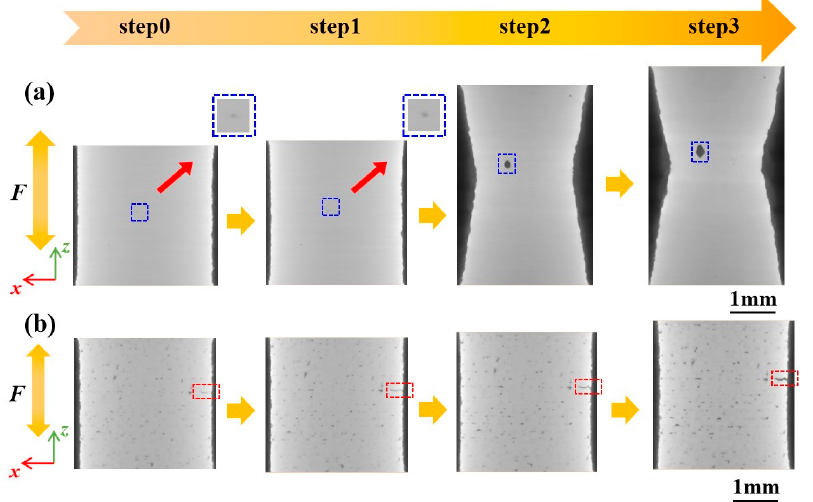
Figure 5. Visualization of critical defect evolution in gauge sections for ( a ) Specimen 400 and ( b ) Specimen 1000.